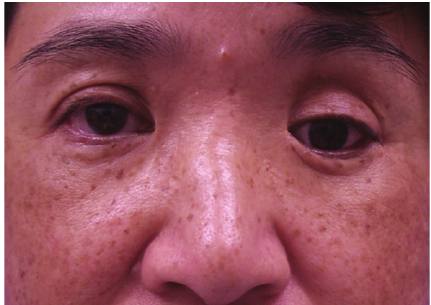
Figure 3: Postoperative 6 months after aponeurotic surgery. Dehiscence of repaired aponeurosis developed (Case 1).